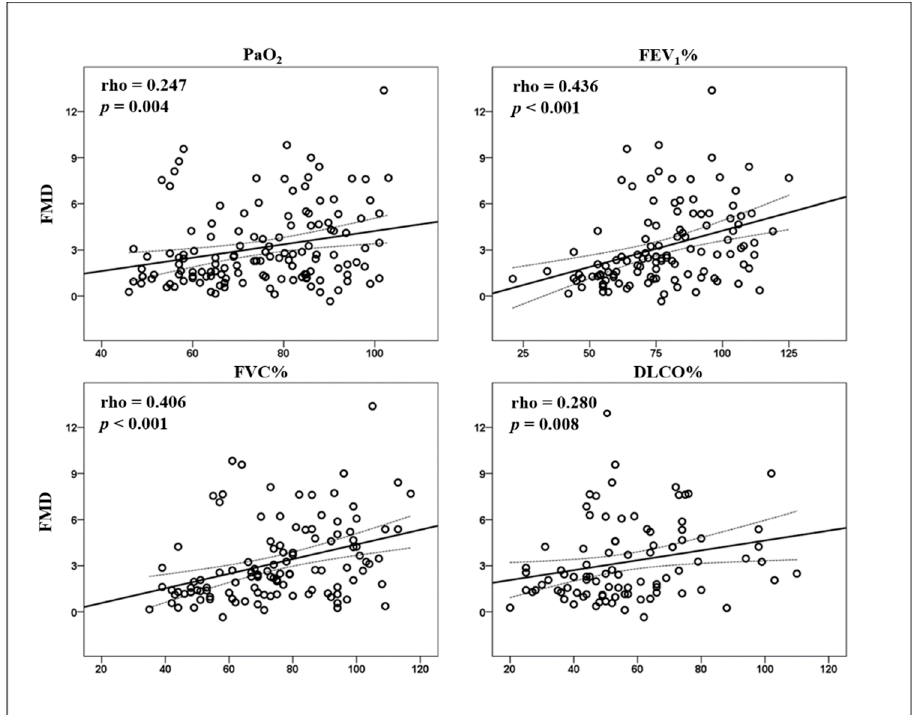
Figure 3. Scatter plot of Spearman’s correlations between flow-mediated dilation (FMD) and arterial oxygen tension (PaO 2 ), forced expiratory volume in 1 s (FEV 1 %), forced vital capacity (FVC%), and diffusing capacity for carbon monoxide (DLCO%) in convalescent coronavirus disease 2019 (COVID-19) patients.